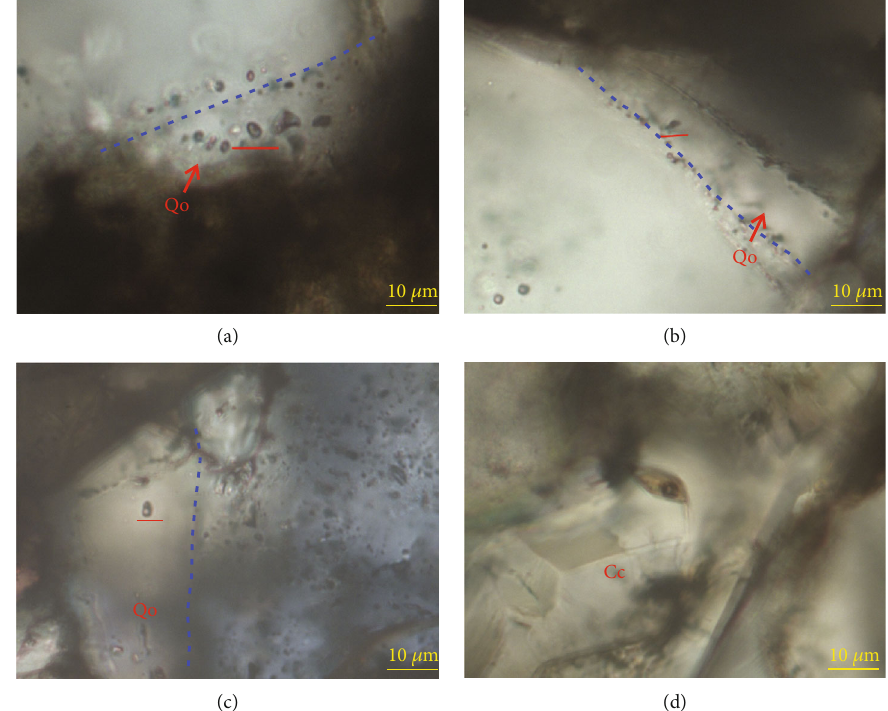
Figure 10: Petrography of fl uid inclusions within quartz overgrowths (Qo) and carbonate cementation (Cc) in